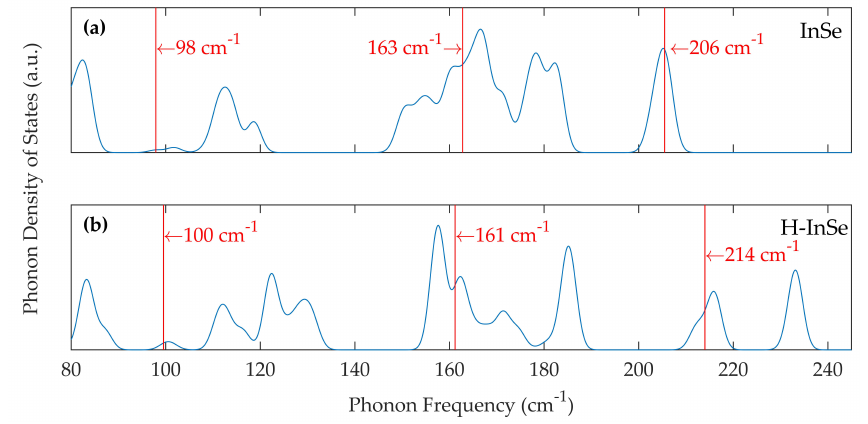
Figure 4. DFT-calculated phonon density of states in: ( a ) Bulk pristine γ -InSe, using a 3 × 3 × 2 supercell. ( b ) Bulk γ -InSe intercalated with H 2 , as shown in Figure 1b, using a 3 × 3 × 2 supercell. The phonon density of states are Gaussian broadened with σ = 1.5 cm − 1 . Vertical red lines in ( a , b ) mark the position of Raman active modes. These correspond to the peaks in Figure